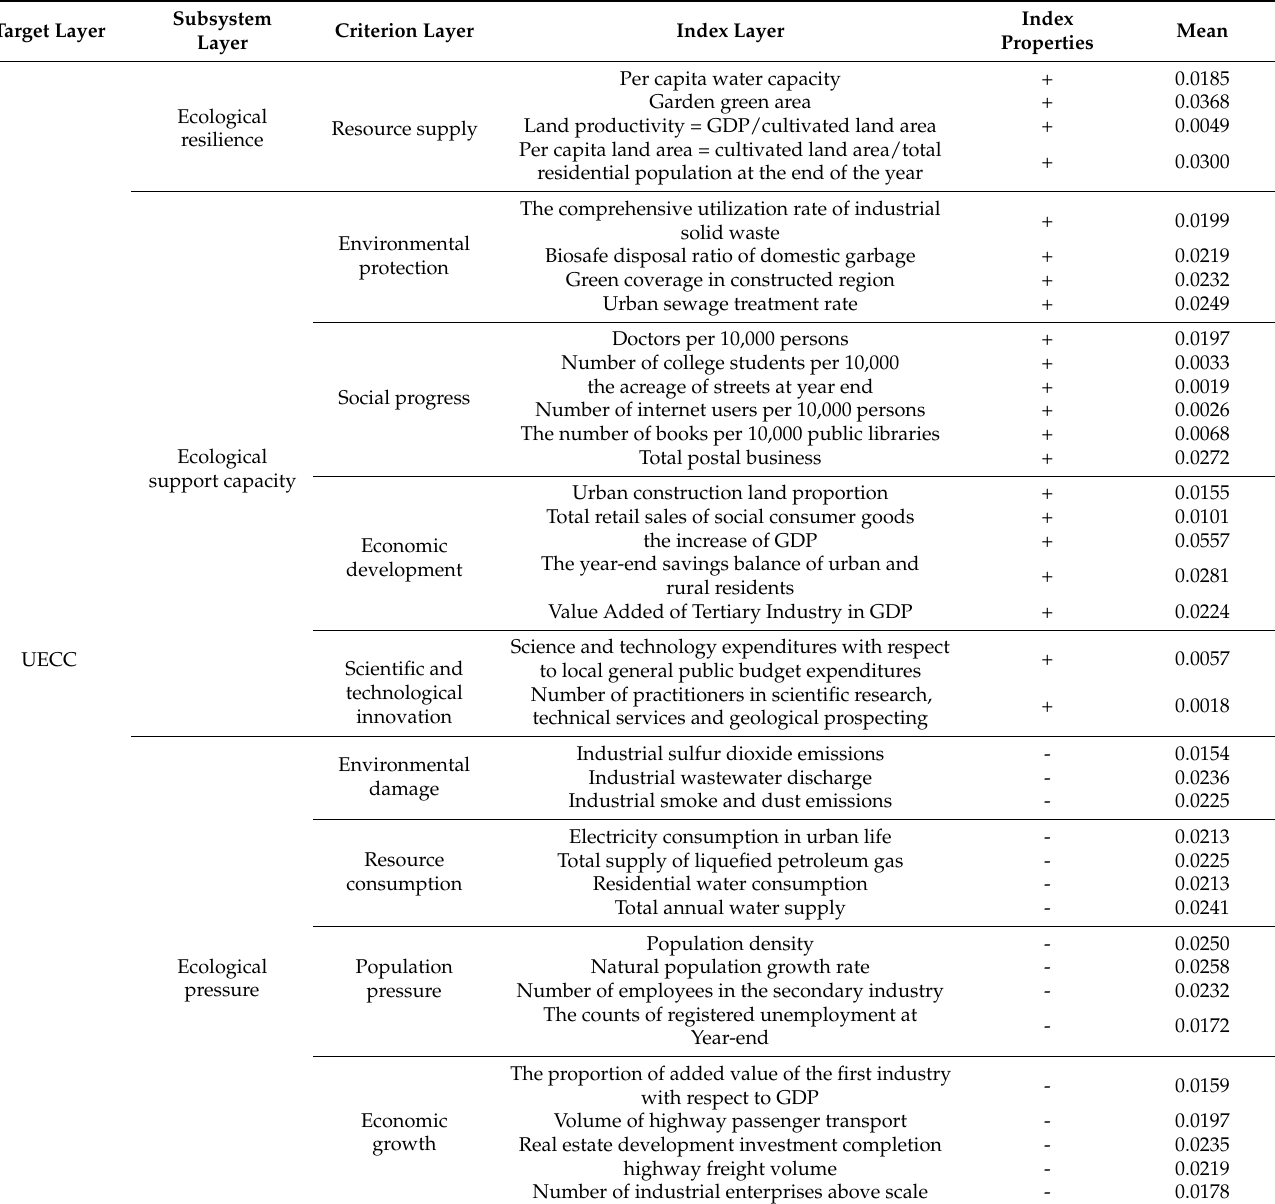
Table 2. Comprehensive evaluation index system of the UECC in the